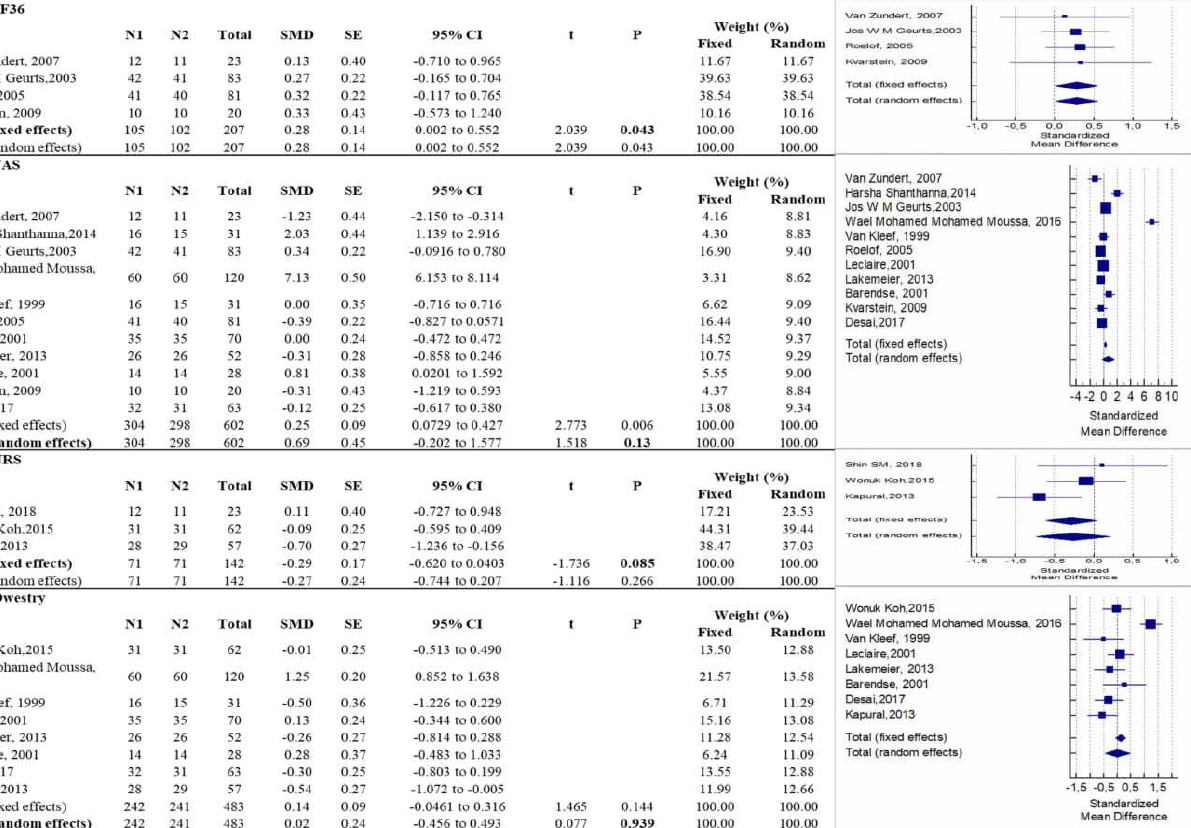
Figure 4. Forest plots showing intervention effects on the spineSF36, VAS, NRS, and Owestry outcomes. The use of fixed or random effects (bold) is chosen based on the results of the Higgins’ heterogeneity test. Note: N1 = no. of patients in the intervention group; N2 = no. of patients in the control group; SMD = standardized mean difference; CI = confidence interval .